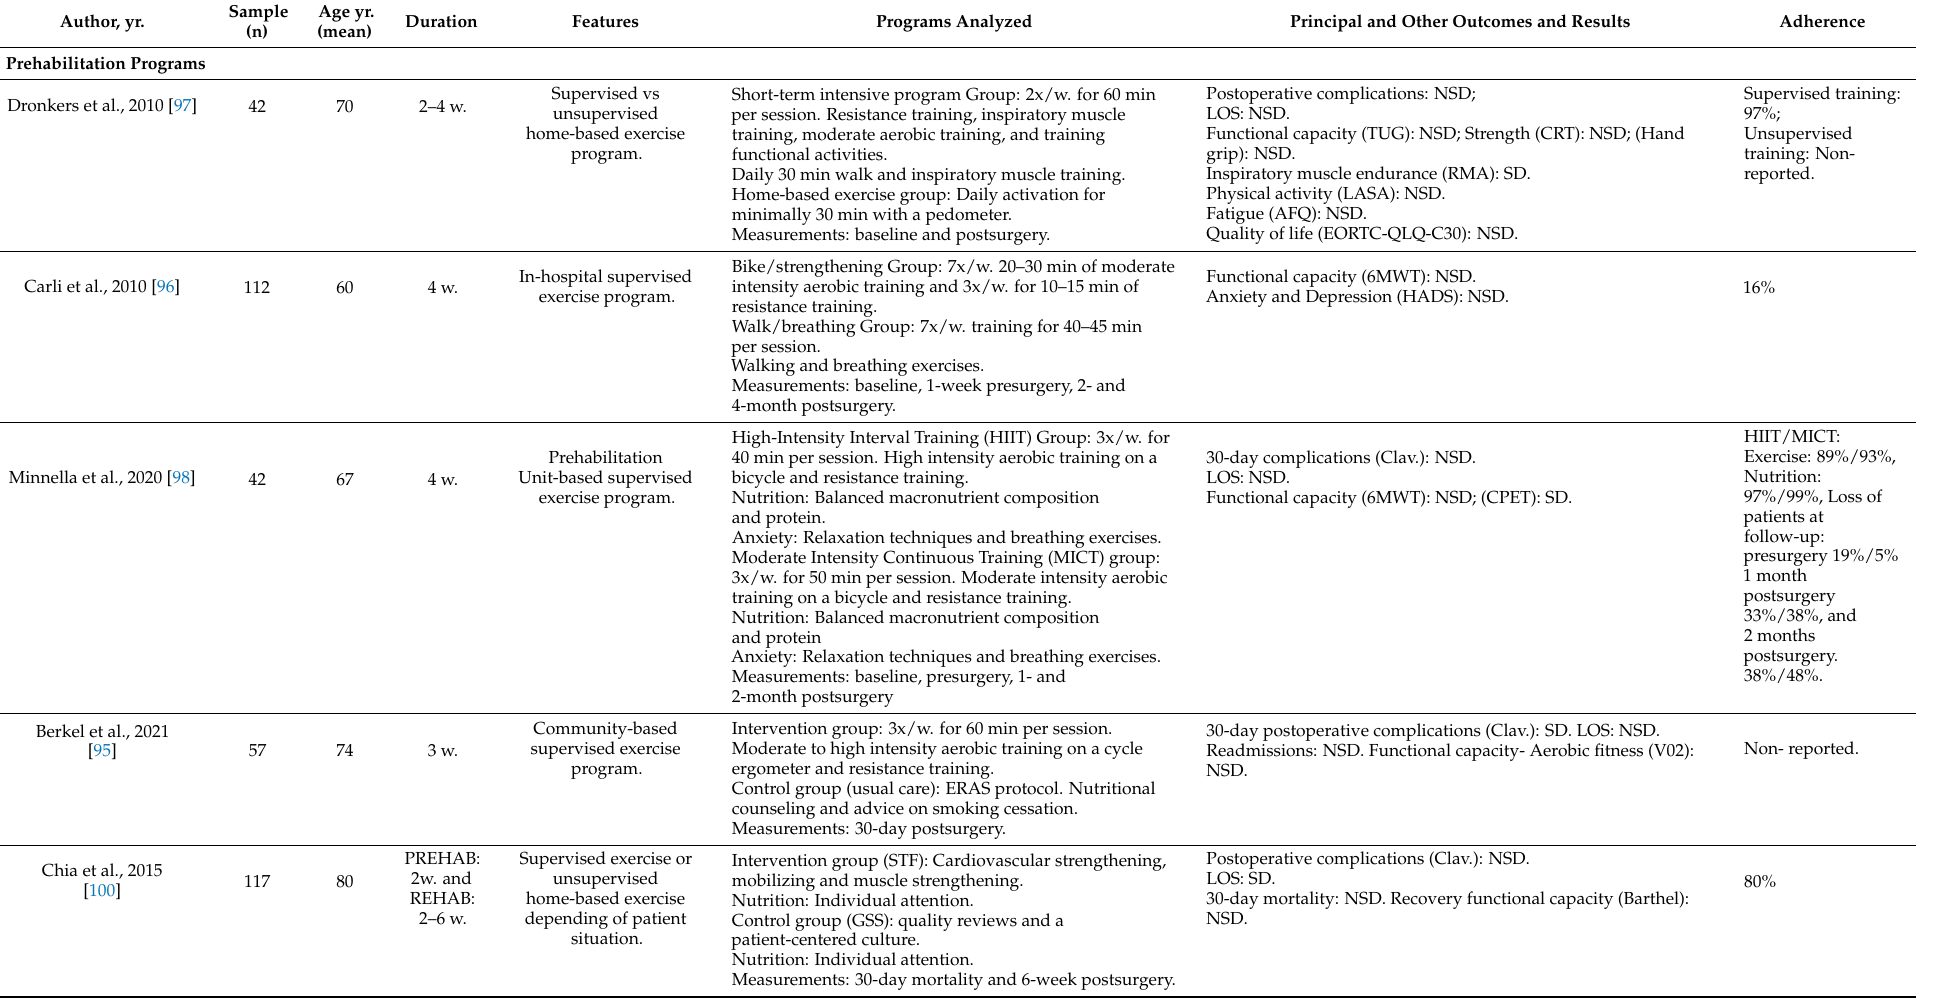
Table 3. Description of interventions and results of randomized controlled trials in older than 60 years with